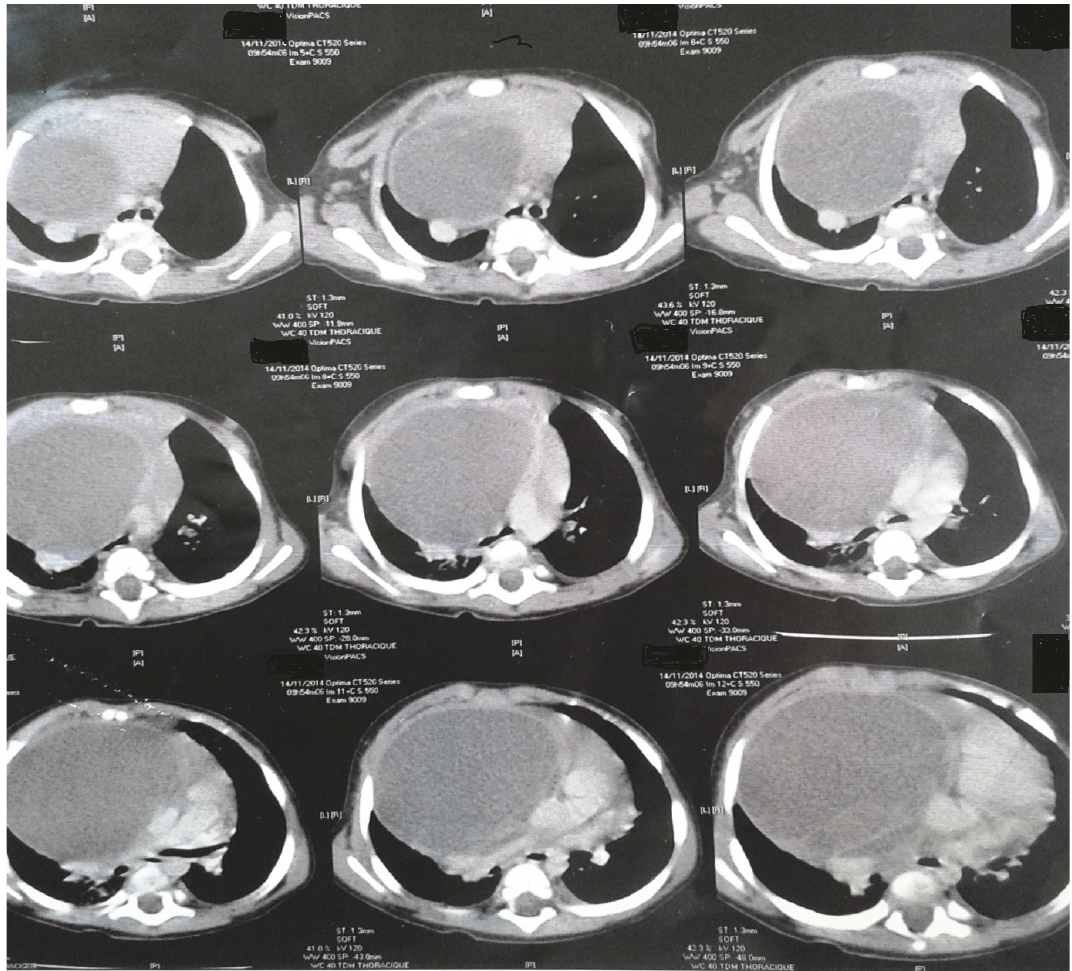
Figure 3: CT scan showing aspects of mediastinal teratoma: a combined cystic-solid tumour with walls of variable thickness.